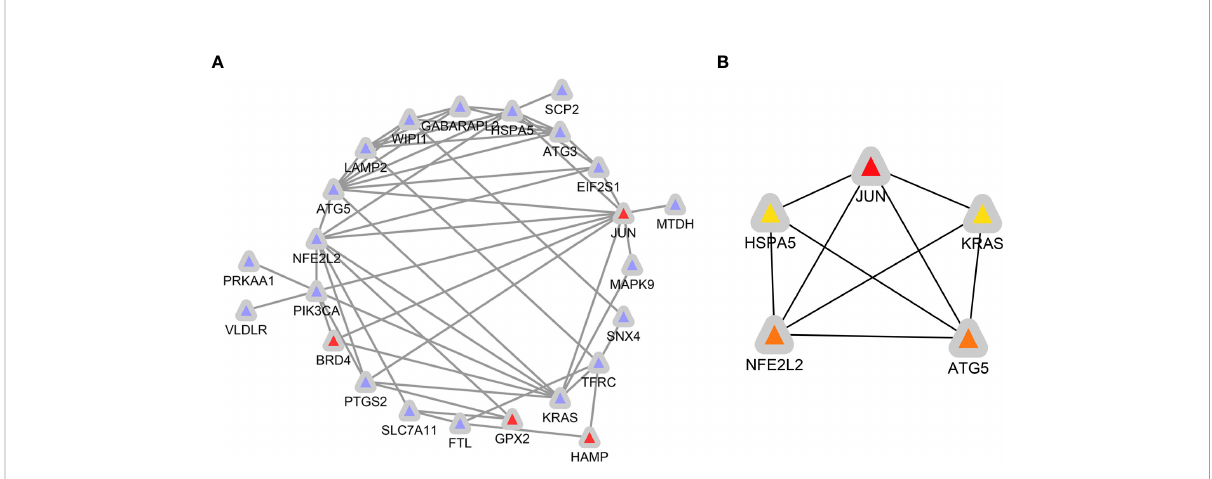
FIGURE 8 Identi fi cation offerroptosis-related hub genes in diabetic islets. (A) PPI network constructed with ferroptosis-related DE-mRNAs were performed using the STRING. The nodes represent proteins, and the edges represent the interaction of the proteins. Blue, downregulation. red, upregulation. (B) Cytohubba in Cytoscape was used to fi nd the top fi ve hub genes in the PPI network by Degree. PPI network of the top 5 hub genes was visualized by Cytoscape, and the top 5 hub genes are displayed from red (high Degree value) to yellow (low Degree